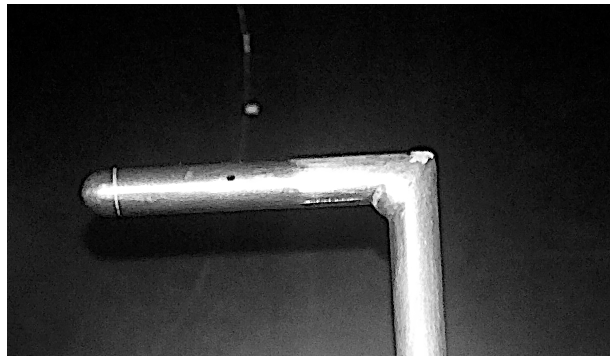
Fig. 1. The static pressure probe .